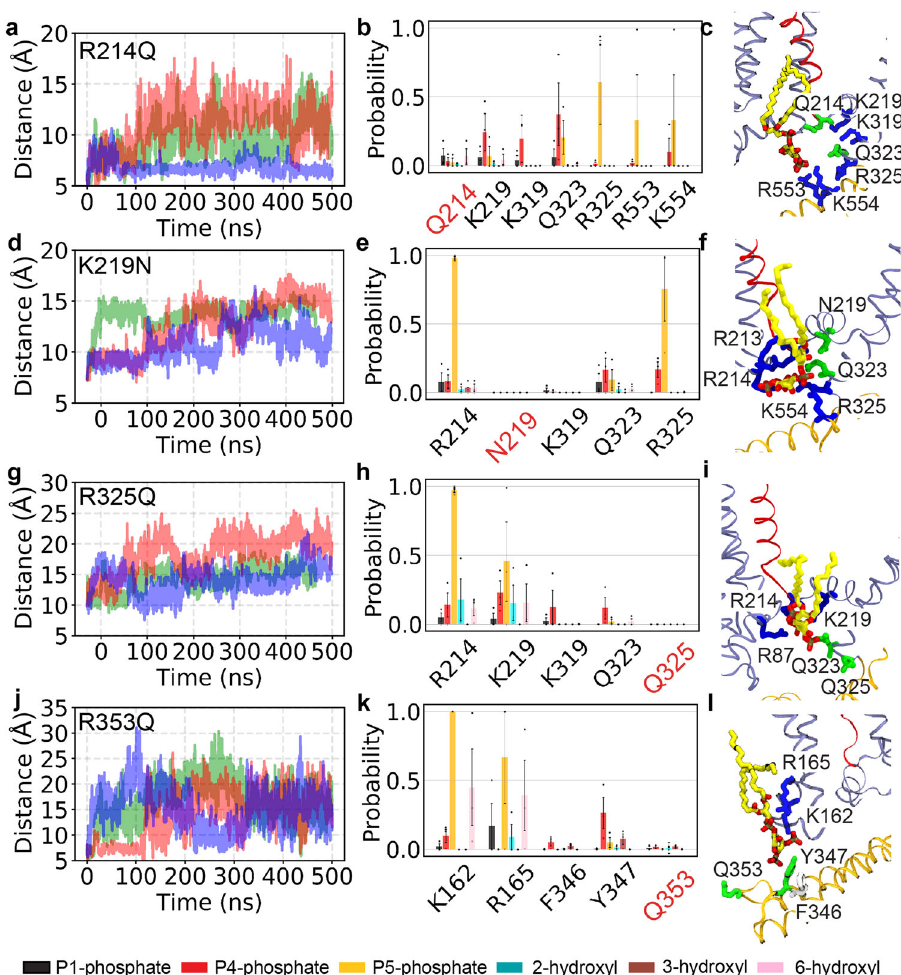
Fig. 3 Charge-neutralizing mutations disrupt PIP 2 binding to the mutated residues in the open K v 7.2 channel. a , d , g , j Time evolution of the distance between the COM of PIP 2 headgroup and the COM of the mutated residue upon introducing mutations including R214Q ( a ), K219N ( d ), R325Q ( g ), and R353Q ( j ) in PIP 2 -bound K v 7.2 channel in an open state from three independent simulations (different colors). Introduction of these mutations resulted in the dissociation of bound PIP 2 lipid, as indicated by the distance increase. b , e , h , k The contact probability for each chemical moiety of PIP 2 headgroup with the key residues in open K v 7.2 channels containing R214Q ( b ), K219N ( e ), R325Q ( h ), and R353Q ( k ). The chemical moieties of PIP 2 headgroup include P1- phosphate (black), P4-phosphate (red), P5-phosphate (orange), 2-hydroxyl (cyan), 3-hydroxyl (brown), and 6-hydroxyl (pink) group of the inositol ring. A heavy-atom distance cutoff of 4 Å was used to de fi ne a contact between a residue and a phosphate group of PIP 2 , whereas a 3.5 Å cutoff was used to de fi ne a contact between a residue and a hydroxyl group of PIP 2 . Analysis of the contact probabilities was performed over the last 200 ns of the simulation trajectories. The number of PIP 2 interacting events: R214Q ( n = 3), K219N ( n = 3), R325Q ( n = 3), and R353Q ( n = 3). Data represent mean ± SEM for 3 independent trajectories. c , f , i , l PIP 2 coordination in Site-O4 of K v 7.2-R214Q ( c ), K v 7.2-K219N ( f ), and K v 7.2-R325Q ( i ) and in Site-O1 of K v 7.2-R353Q ( l ) channel at the end of the respective simulations. The protein is shown in ribbon representation with the S4 in red, helices A and B in brown, and the rest of the protein in ice blue. A PIP 2 lipid (carbon atoms in yellow, oxygen in red, and phosphorus in tan) and the residues of the binding pocket at each site are shown in sticks (basic residues in blue, polar in green, acidic in red, and hydrophobic in